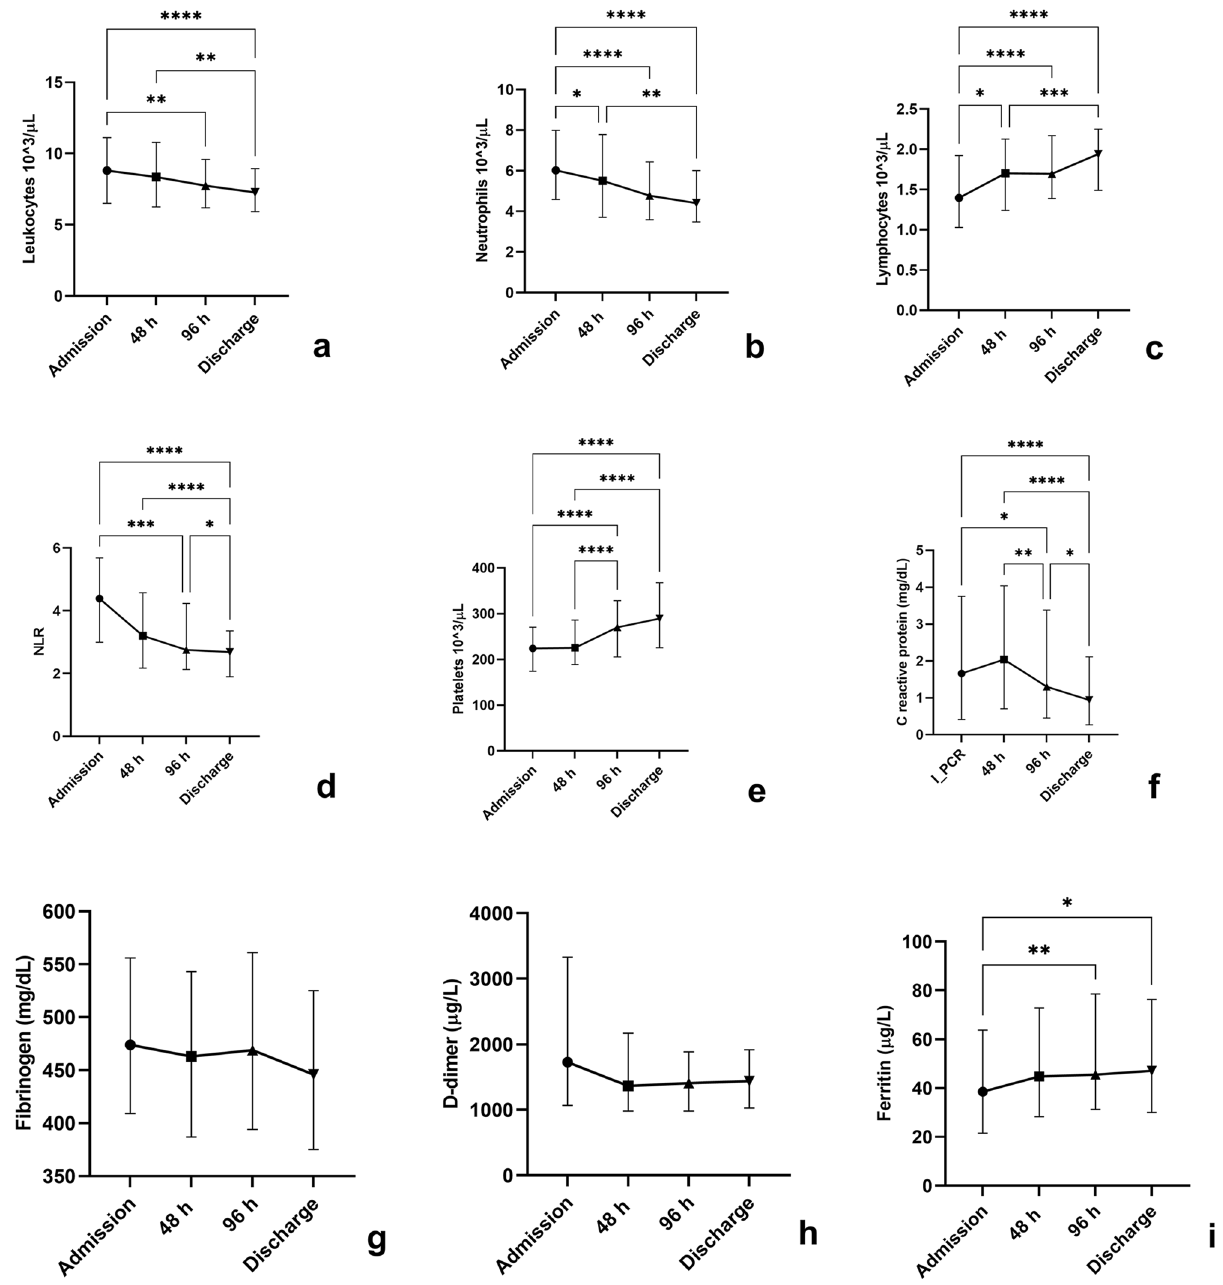
Figure 1. Leukocytes ( a ), neutrophils ( b ), lymphocytes ( c ), neutrophils to lymphocytes (NLR) ratio ( d ), platelets ( e ), C reactive protein ( f ), fibrinogen ( g ), D-dimer ( h ) and ferritin ( i ) values assessed at admission, at 48 and 96 h from admission and at discharge. Data are shown as mean with standard deviation. *P ≤ 0.05, **P ≤ 0.01, ***P ≤ 0.001, ****P ≤